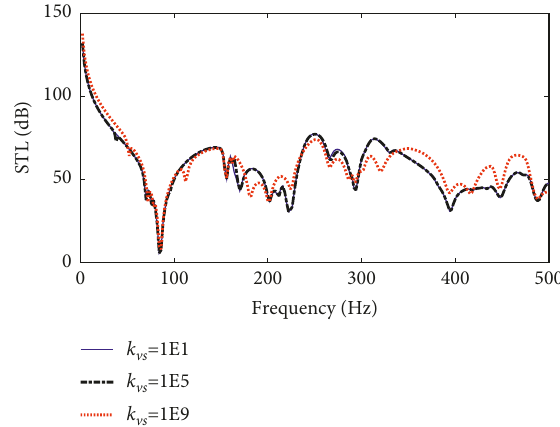
Figure 16: Vibration velocity response at the point on the surface of panel 2 with and without an acoustic cavity.